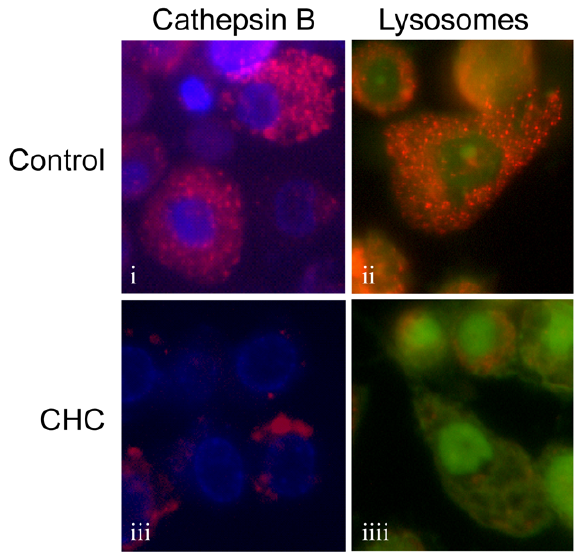
Figure 5. Cholesterol crystals (CHCs) cause destabilization of lysosomes and leakage of cathepsin B into the cytoplasm. CHC- treated or untreated live THP-1 macrophages were stained with cathepsin B substrate z-Arg-Arg-cresyl violet (panels i, iii) or with acridine orange (panels ii, iiii). The fluorescent cresyl violet group of z- Arg-Arg-cresyl violet is dequenched upon cleavage of one or both of the arginines by cathepsin B. Acridine orange aggregates in the acidic pH of lysosomes, which changes the fluorescence emission of the dye from green to red. The images are representative of 3 experiments.